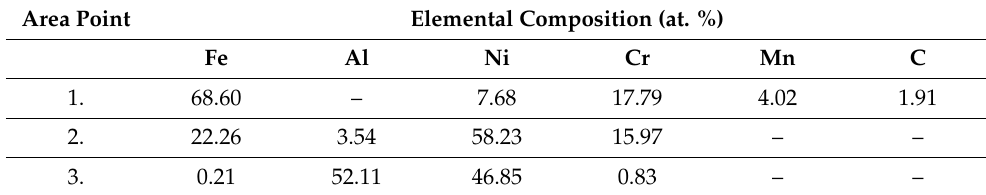
Table 5. The EDS analysis of aluminized samples formed onto AISI 304L samples after nickel electrodeposition. Please note that point 1 is the chemical composition of substrate, while point 2 indicates the interdiffusion zone (IDZ), and the outer layer is shown in point 3. Please refer to Figure 4 for point area details.